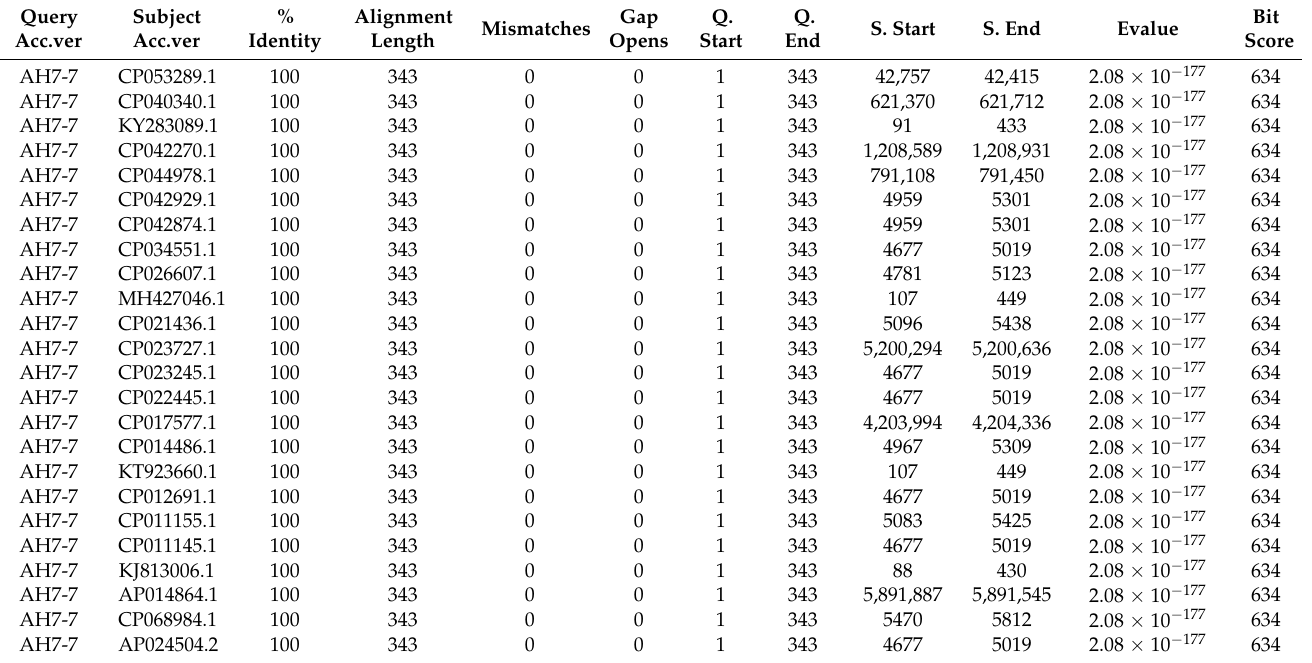
Table A2. Blast results of the gyrB